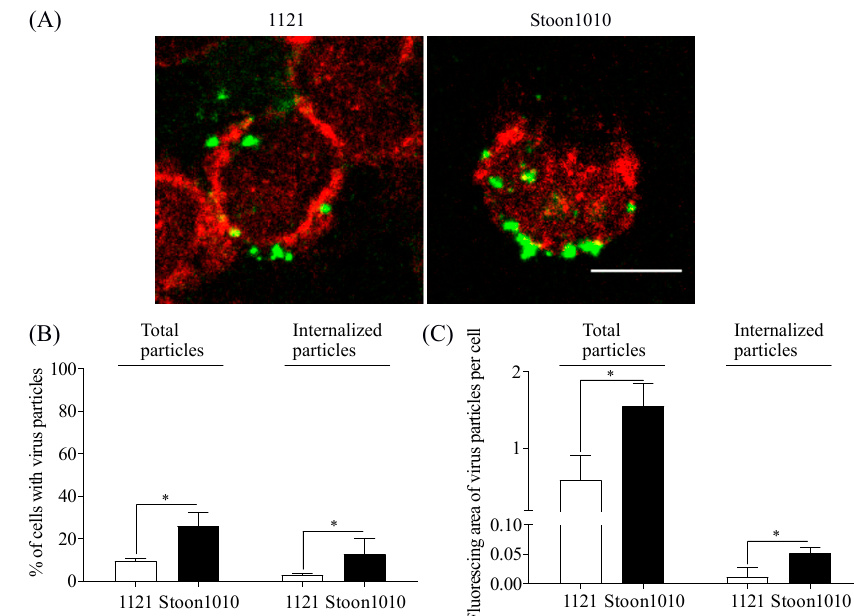
Figure 7. PCV2 internalization into T-lymphoblasts. Cells were incubated with PCV2 particles at 37 ° C for 1 h, after which the virus was removed and cells were fixed. PCV2 particles were stained in green, while T-lymphoblasts were stained in red. ( A ) Visualization of PCV2 particles internalized into T-lymphoblasts was performed by confocal microscopy. Some green virus particles were sticking to the cell membrane, while others were found inside the red cell rings and were regarded as internalized particles. Scale bar = 8 µm. ( B ) The percent of T-lymphoblasts with virus (total particles = surface sticking particles + internalized particles) and the percent of T-lymphoblasts with internalized particles was counted. ( C ) The fluorescing area of total virus particles and internalized virus particles per cell was quantified with ImageJ. Data represent means ± SD of triplicate assays. * p < 0.05.